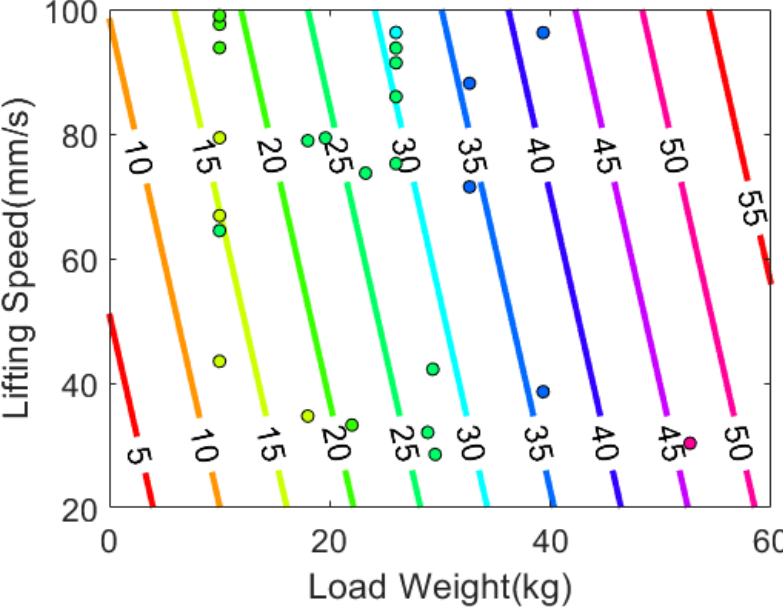
Figure 5. Non-1RM data points and 1RM decision boundaries based on the equation, 1RM = −0.3908 + 0.8251𝑊 + 0.1054𝑣 . The color of each data point indicates the actual 1RM.